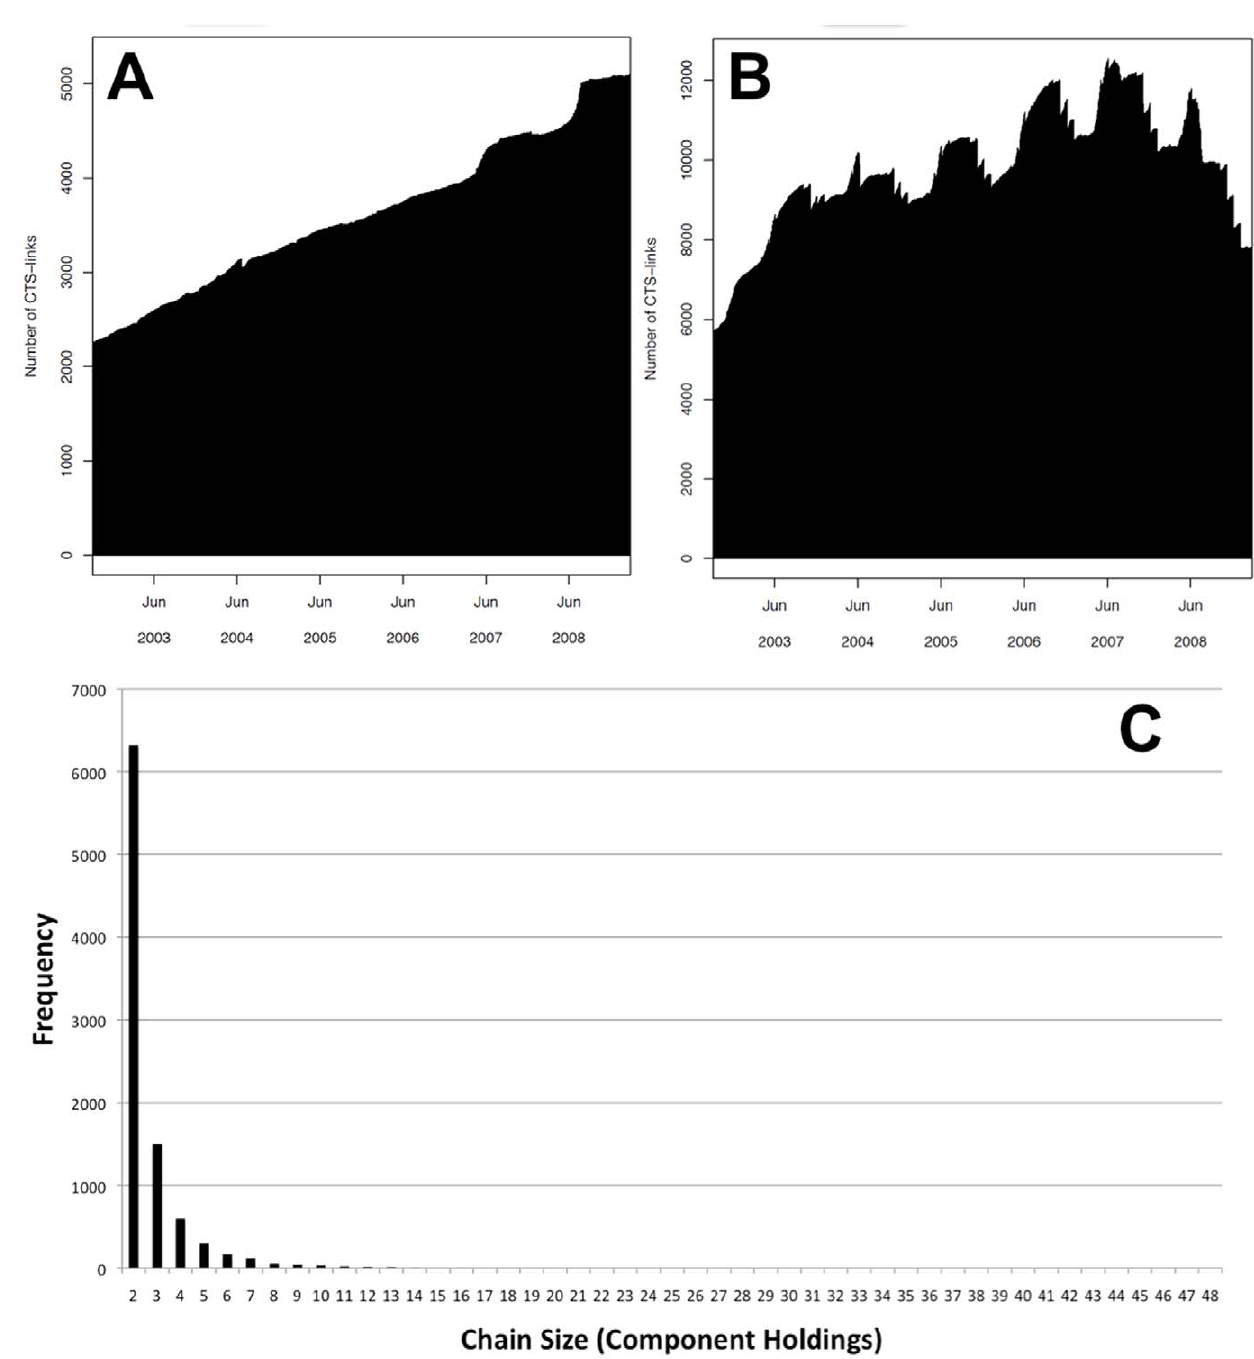
Figure 3. Daily total number of active CTS Links. The daily number of active CTS Links classed as Shared Facility (A) and Additional Land (B) from 2003 to 2008. (C) Shows the frequency distribution of CTS Chain sizes; the outlier chain of size 242 was removed from this chart, whilst the second largest chain consist of 48 component holdings.